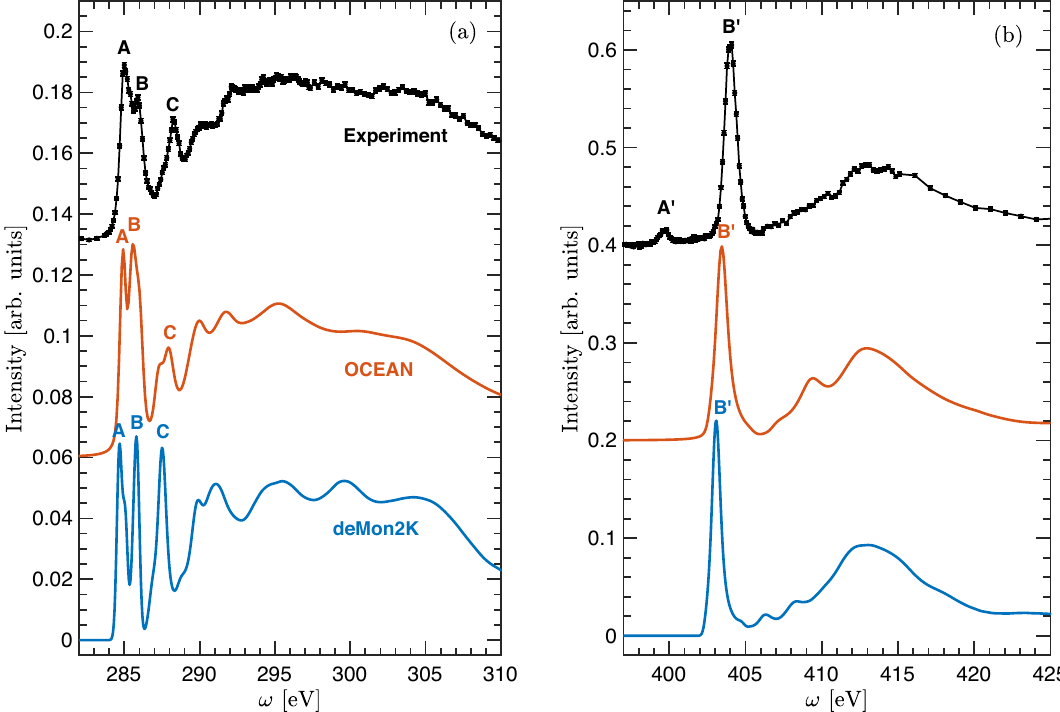
Figure 3. Experimental and theoretical 1s carbon ( a ) and nitrogen ( b ) X-ray Raman spectra of HNS.